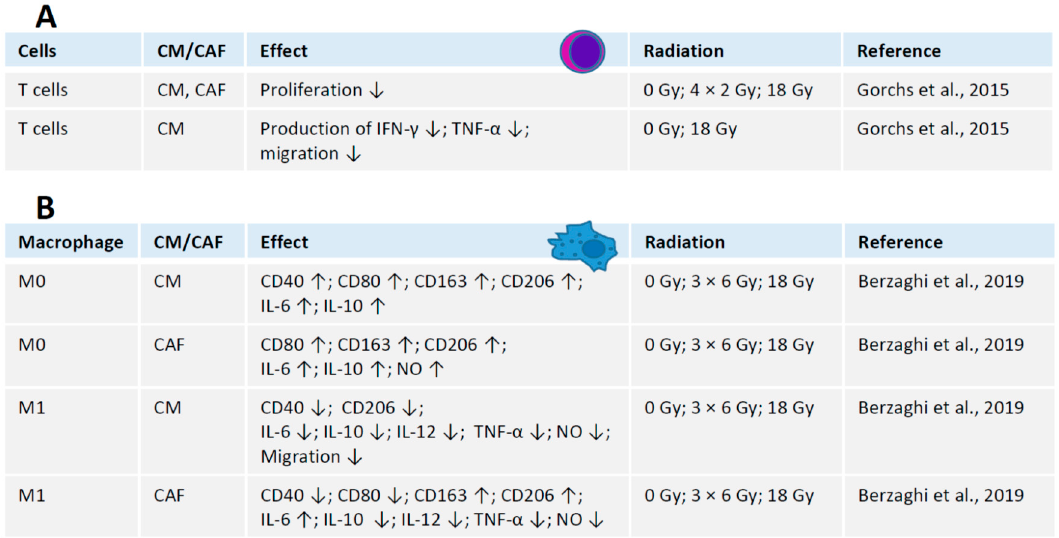
Figure 3. Interaction between CAFs, immune cells and radiation. ( A ) Interaction between irradiated CAFs and T cells. ( B ) Interaction between irradiated CAFs and macrophages. M0, resting macrophages; M1, polarized activated pro-inflammatory macrophages. CAF, co-culture with cancer-associated fibroblasts; CM, conditioned medium from cancer-associated fibroblasts. Summarized from Gorchs et al., 2015 [11] and Berzaghi et al., 2019 [7].